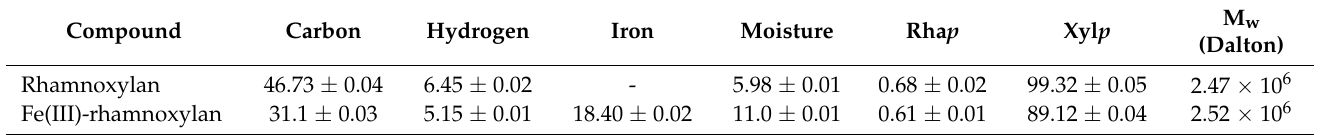
Table 1. Elemental, moisture, monosaccharide and GPC analysis data (% w/w on dry substance basis).